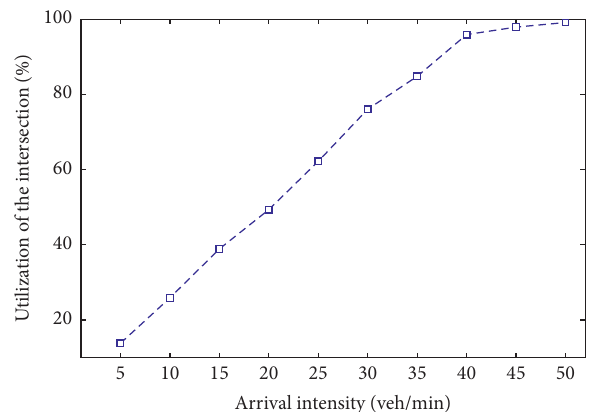
Figure 14: First case study: intersection’s utilization for varying values of the arrival intensity, λ .